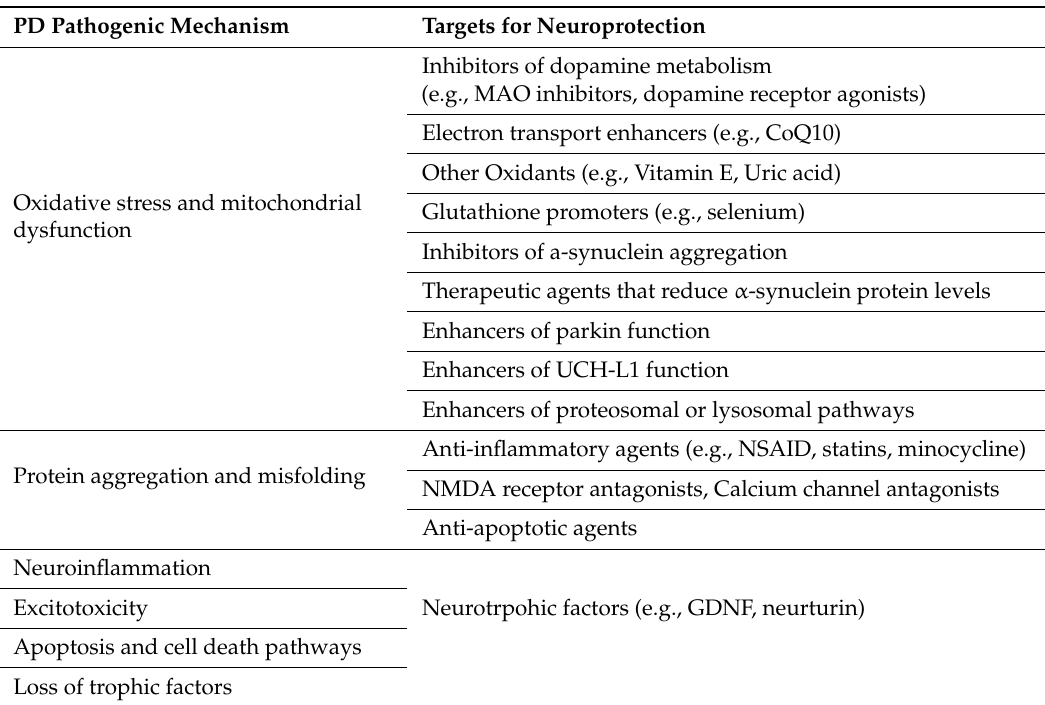
Table 1. Mechanism of Parkinson’s disease (PD) pathogenesis and possible targets for therapy (adopted from Yacoubian TA et al. , 2009,